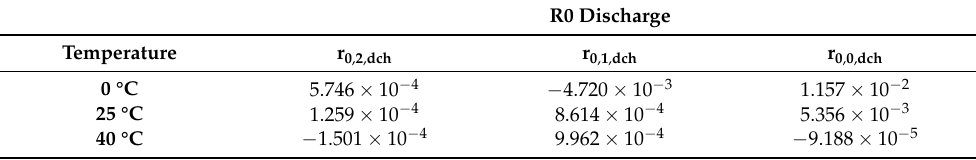
Table A11. R0 models parameters in